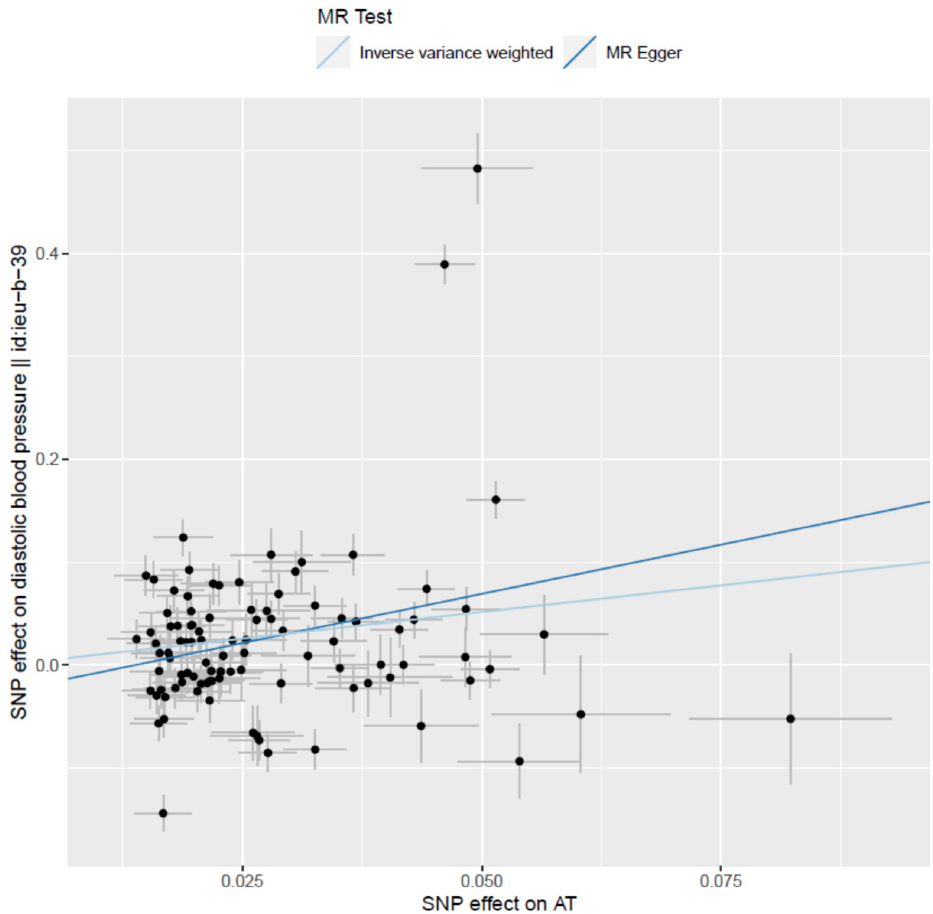
Fig 2. Results of Mendelian Randomization analyses for arteriolar tortuosity (AT) as a causal influence on diastolic blood pressure (DBP). Footnotes: Among 108 SNPs that showed independent genome-wide significant associations with AT in conditional regression analysis, 99 had published information available on their association with DBP in non-UK-Biobank studies [reference: decipher "id:ieu-b-39" and remove from y-axis label]. Single points in the graph represent co-ordinates determined by the effect of each specific SNP on DBP (in non-Biobank studies) and AT (in UK Biobank). Outlying SNPs are identified individually by rs-number. [see comment below.]. MR analyses were conducted with all 99 SNPs as instrumental variables using the conventional inverse-variance-weighted (IVW) and Egger methods. The slope of each line corresponds to the estimated MR effect for each method. Significance tests for the MR slope (Table I in S1 Table) were: p = 0.00004 (3.55E-05) by MR-IVW. p = 0.0050 (0.005017737) by MR-Egger. Using a weighted-median MR method (which is less sensitive to outliers), the corresponding p-value was p = 0.00001